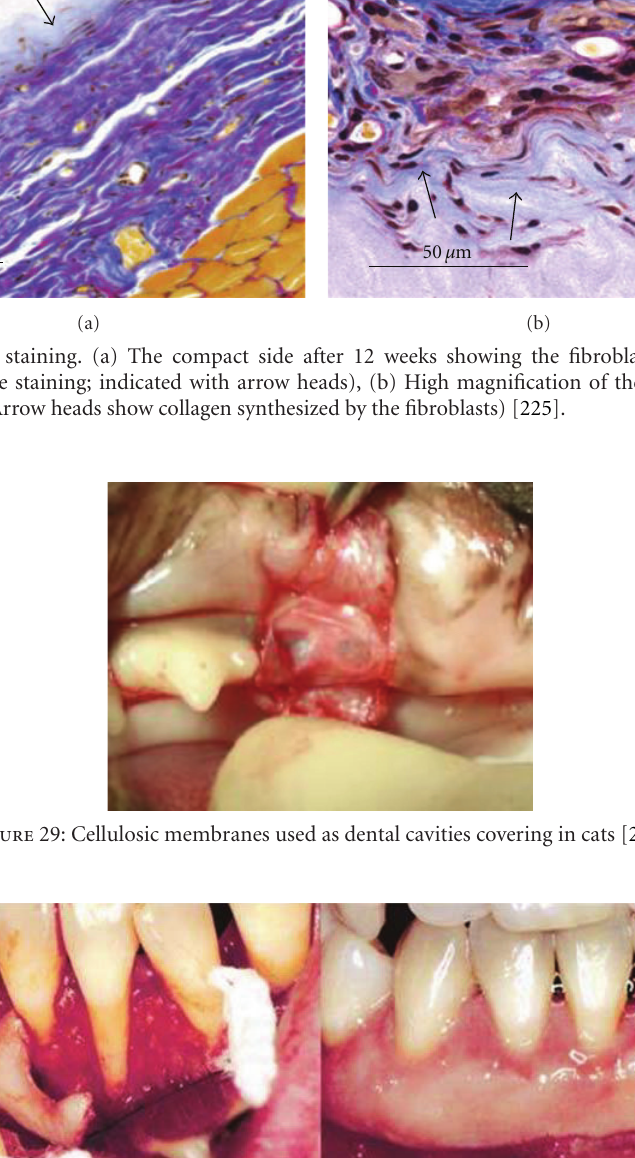
Before After Figure 30: Nanocellulose used in dental tissue regeneration in 39-year-old female